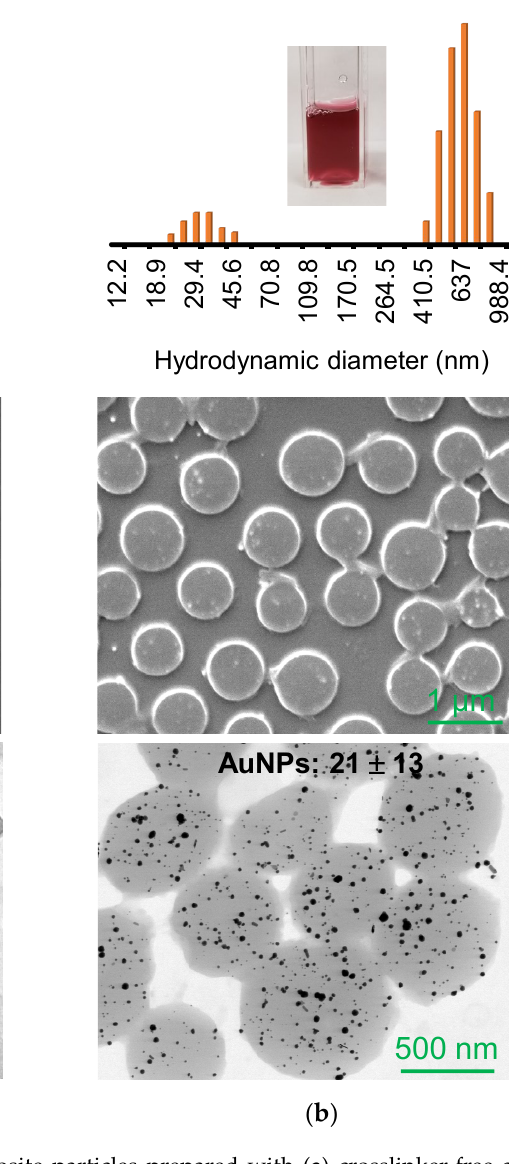
Figure 2. SEM and TEM images of composite particles prepared with ( a ) crosslinker-free and ( b ) crosslinked PNIPAM and their corresponding size distribution by DLS.